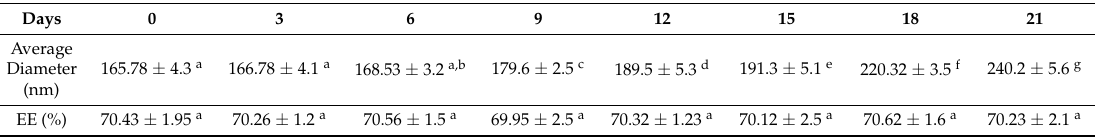
Table 3. The average diameter (particle size) of C3G liposome measured over three weeks consecutively.